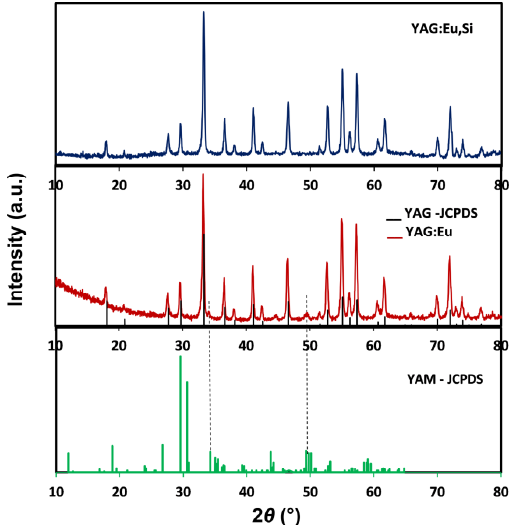
Fig. 1 XRD patterns of YAG:Eu and YAG:Eu,Si compared with the JCPDS data